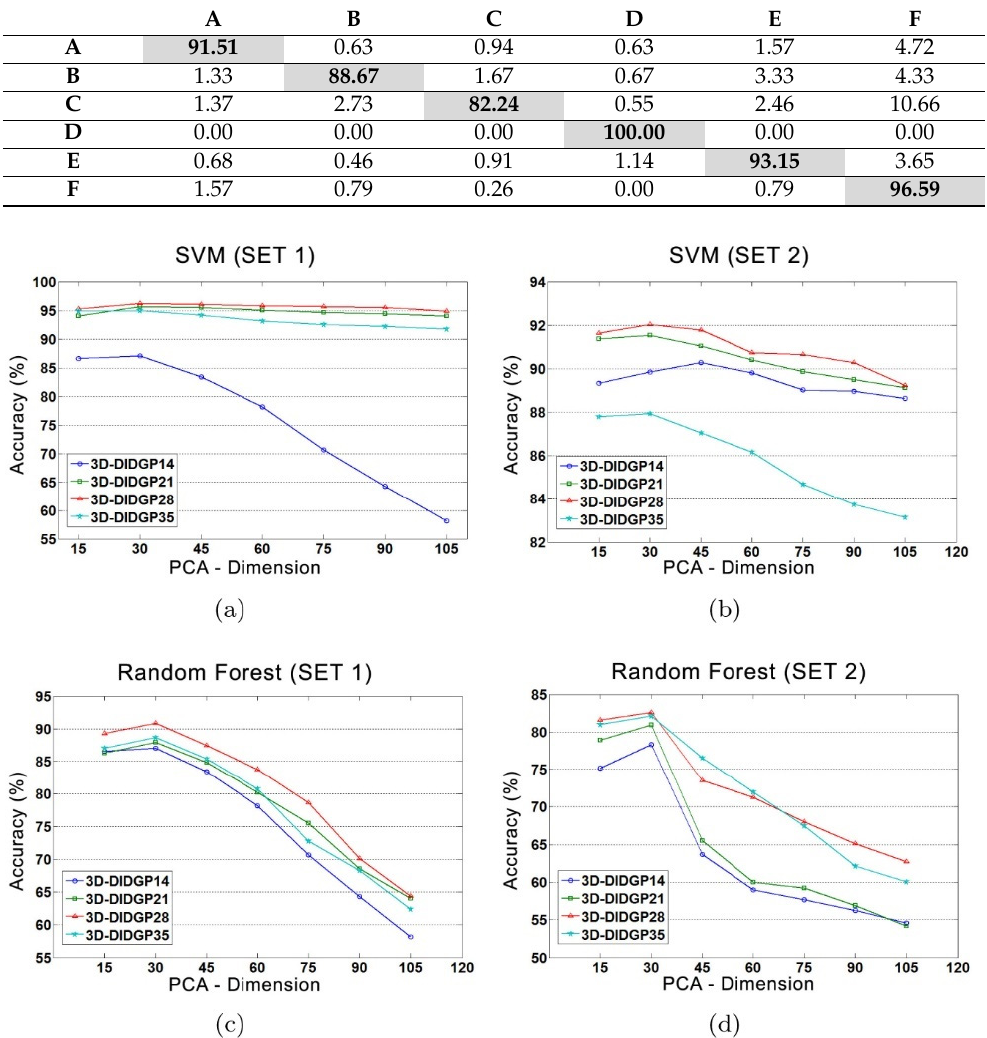
Figure 13. Comparison of accuracy under different conditions ( a , b ) show accuracy of different Cuboid size on SVM against PCA with different dimensions. ( c , d ) give accuracy of different Cuboid size on Random Forest against PCA with different dimensions.